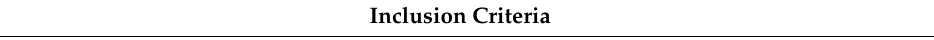
Table 1. Inclusion and exclusion criteria.